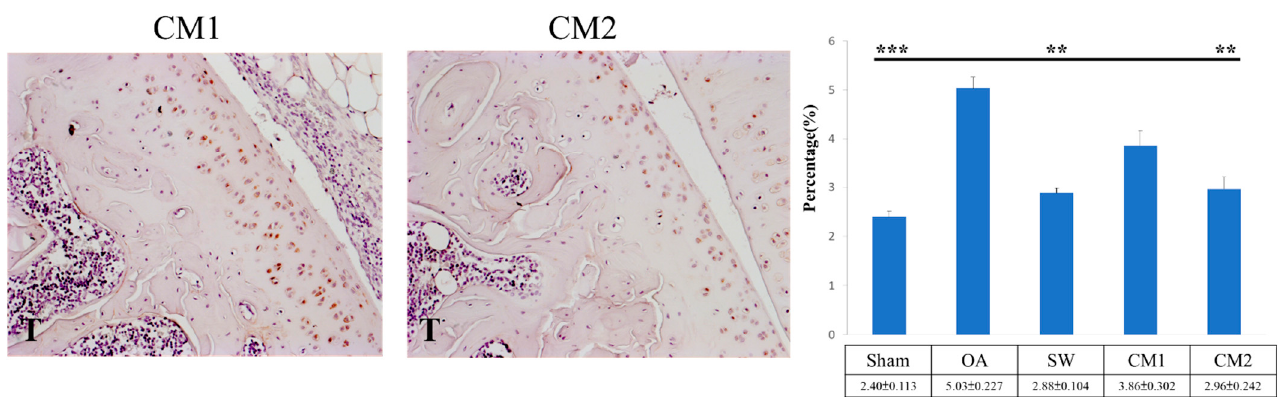
Figure 6. Immunohistochemical analysis for ( A ) BMP2, ( B ) BMP5, and ( C ) BMP6 ( × 400 magnification), and the percentage of BMP2, BMP5, and BMP6 expression in the articular cartilage of the tibia for each group is shown on the left. The 100 and 200 µ L adipose-derived mesenchymal stem cells-conditioned medium groups are indicated as CM1 and CM2, respectively. SW indicates shockwave. * p < 0.05, ** p < 0.01, and *** p < 0.001 as compared with the osteoarthritis (OA) group. Eight rats were used for each